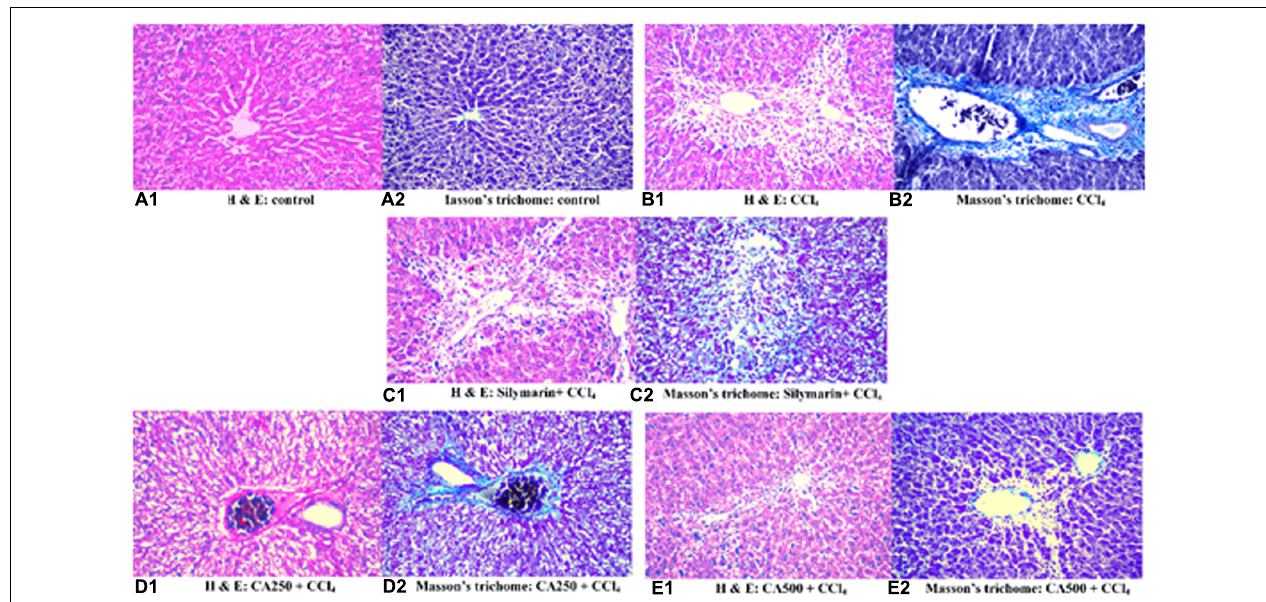
FIGURE 4 | Histopathological sections of liver with CCl 4 induced hepatotoxicity stained with (1) hematoxylin and eosin and (2) Masson’s trichome; (A) control group, (B) CCl 4 group, (C) silymarin + CCl 4 group, (D) CA250 + CCl 4 group, (E) CA500 + CCl 4 group.